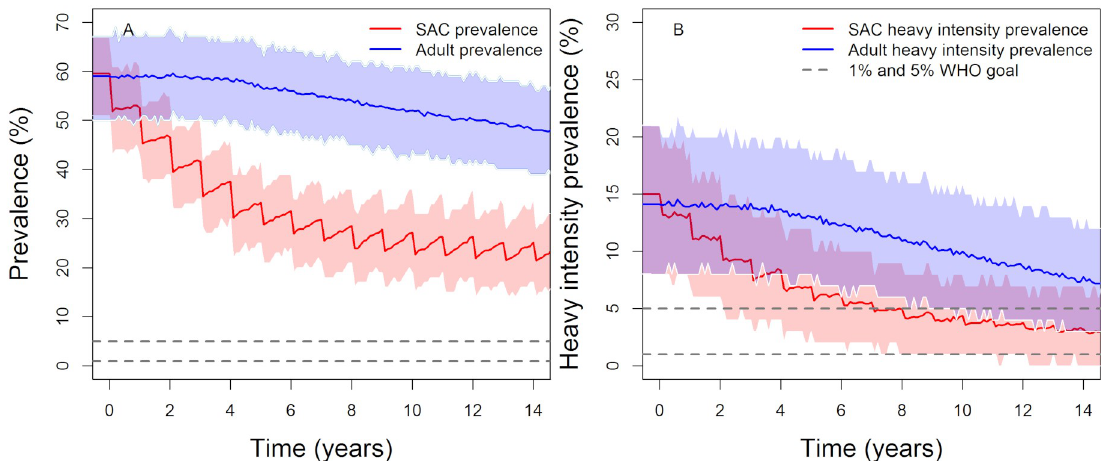
Fig 5. Model projections of annual vaccination in high baseline transmission settings. The duration of vaccine protection is set at 5 years and 1, 6 and 11 years old are vaccinated with a coverage of 85%, 60% and 70% respectively. Graph (A) shows the prevalence of infection, Graph (B) shows the prevalence of heavy-intensity infections, both in school-aged children (SAC) and adults. The average duration of vaccine protection is set at 5 years. Shaded areas (both blue and red) represent the 90% credible interval (90% of the simulated results fall within these shaded